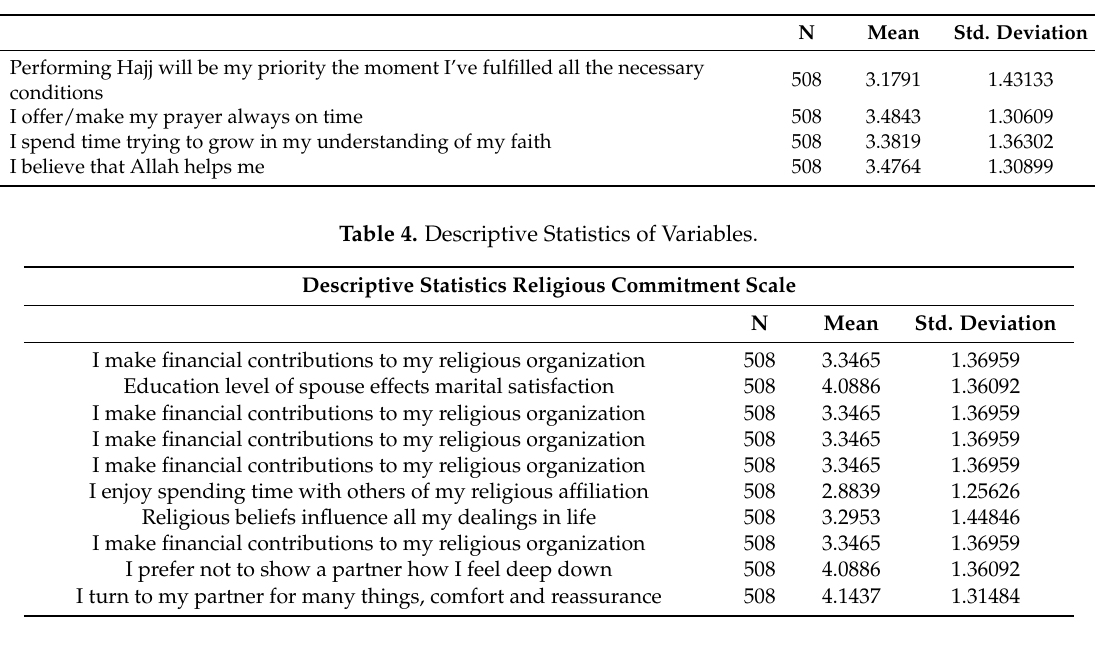
Table 3. Descriptive Statistics of Variables.